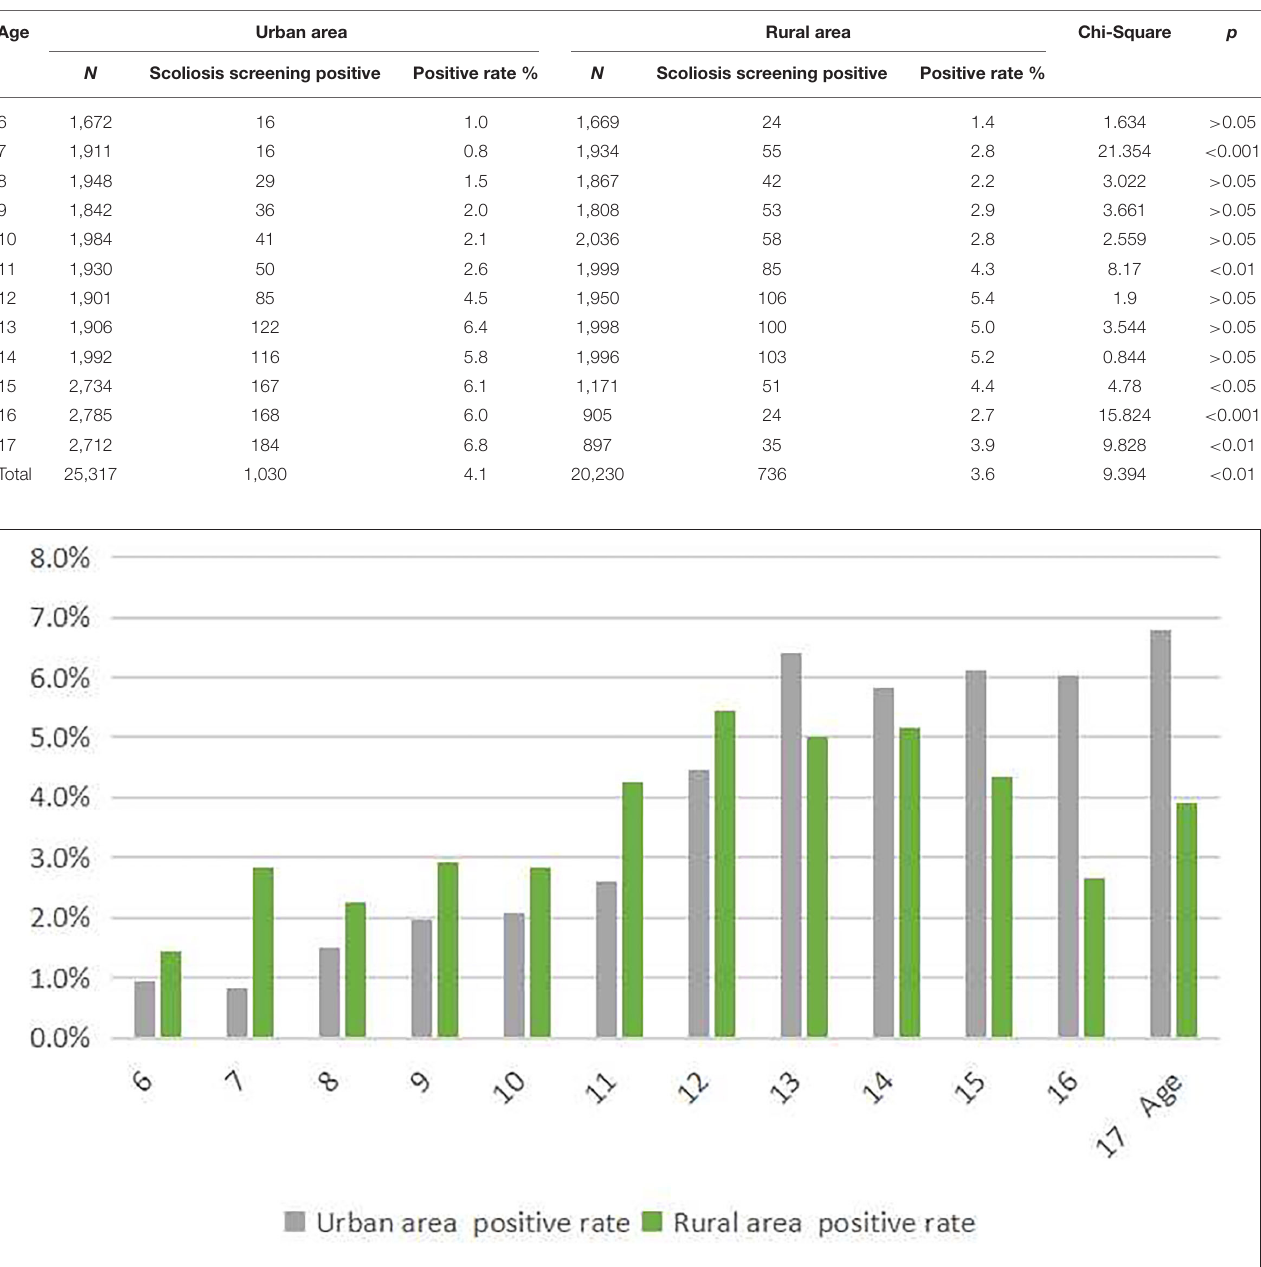
TABLE 1 | The prevalence of scoliosis screening is positive among students stratified by the living area. Age Urban area